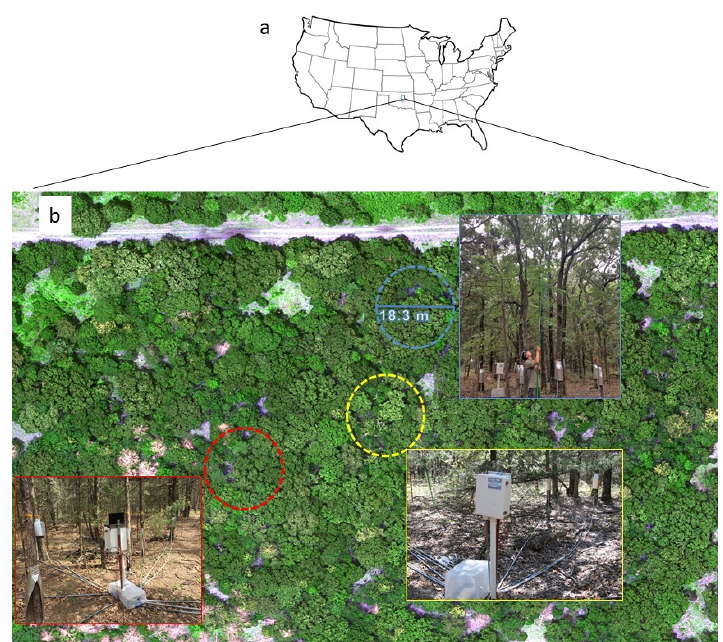
Figure 1. Map showing study location ( a ), aerial photograph of the study site with a picture of individual stands (inset) ( b ). The blue circle is the OAK stand, the yellow circle is the MIX stand, and the red circle is the ERC stand. Aerial photo credit: Nicole Pauley and Bryan Murray. Stand photo credit: Patricia